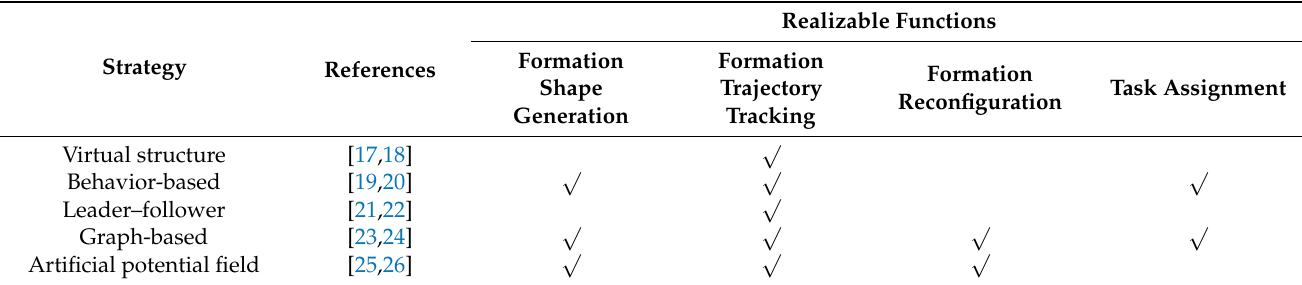
Table 1. Summary of different platoon formation control strategies.